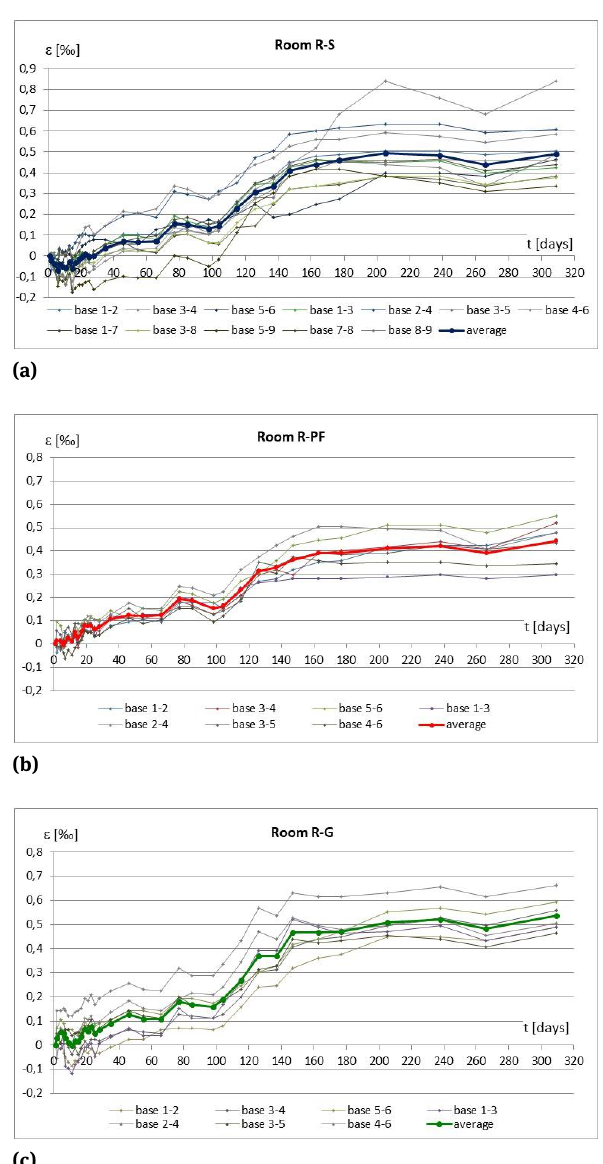
Figure 4: Graphs of strain changes on screed surfaces in each room: a) room R-S, b) room R-PF, c) room